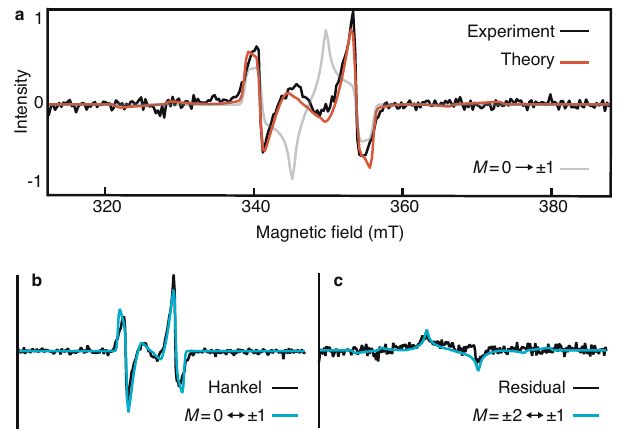
Fig. 2 | Data and calculated EPR spectrum for TIPS-BP1'. a The prompt trEPR spectrumforTIPS-BP1'(black)isanaverage over200 – 400ns (Fig.1a).Theredline comes from the JDE model with best- fi t parameters D =1322±3 MHz, X =59±1 MHz, and β =111.1±0.2 ∘ (see Supplementary Note 2.6). Using the Q 0 model to predict initial populations (gray) does not reproduce the spectrum. b The Hankel spectrum (black) is the dominant signal and is replicated well by a calculated 5 TT 0 ↔ 5 TT ±1 spectrum (blue, JDE model). c The residual spectrum (black) is the difference between the full spectrum in a and the Hankel component in b . It is reproduced (blue, JDE model) with a calculated 5 TT ±1 ↔ 5 TT ±2 spectrum. Any signal fromtripletsisundetectable.Relativeamplitudesofthecalculatedspectrain b and c (blue) are computed from the JDE model and are not adjustable